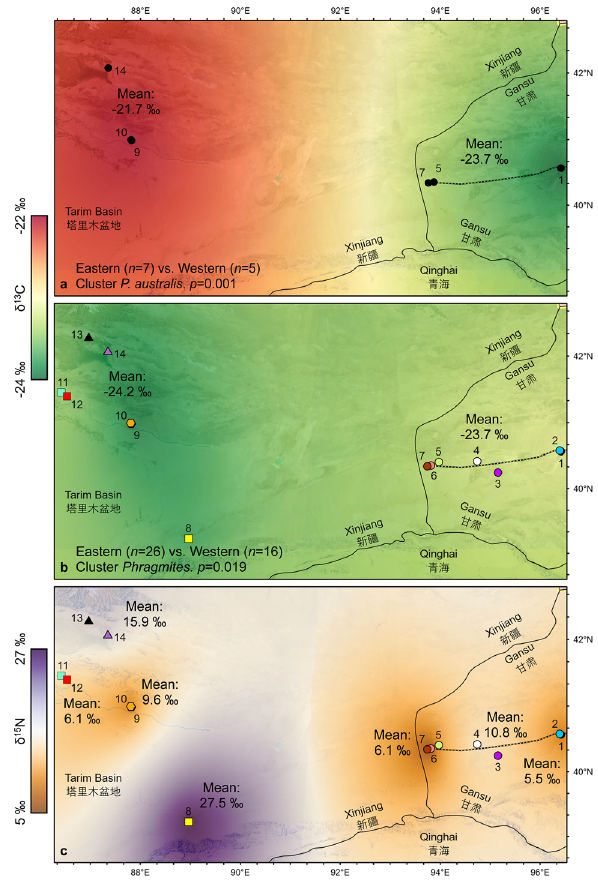
Figure 8. Carbon and nitrogen isoscapes. ( a ) Modern P. australis showing the sharp, 2.0‰ contrast in mean δ 13 C between eastern and western clusters and the two-tailed Student’s t-test p -value from Table 2. ( b ) Ancient Great Wall Phragmites have more homogenous δ 13 C values across eastern and western clusters, with western samples being 0.5‰ lighter than their eastern counterparts on average. Also shown is the two-tailed Student’s t-test p -value for all ancient Phragmites from eastern (Sites 1–7) and western (Sites 8–14) clusters. Although both p -values are < 0.05, ( a ) and ( b ) demonstrate the large 2.5 ‰ difference between modern and ancient samples from the western cluster following 21st Century warming. ( c ) Highly variable δ 15 N values likely suggest evidence of fertilization in some sites, specifically Milan Castle (Site 8) and Sishilidadun Tower (Site 14). Maps were created using the Kriging feature in ArcGIS Pro, whereby color variation in the surface reflects the spatial correlation between δ 13 C or δ 15 N